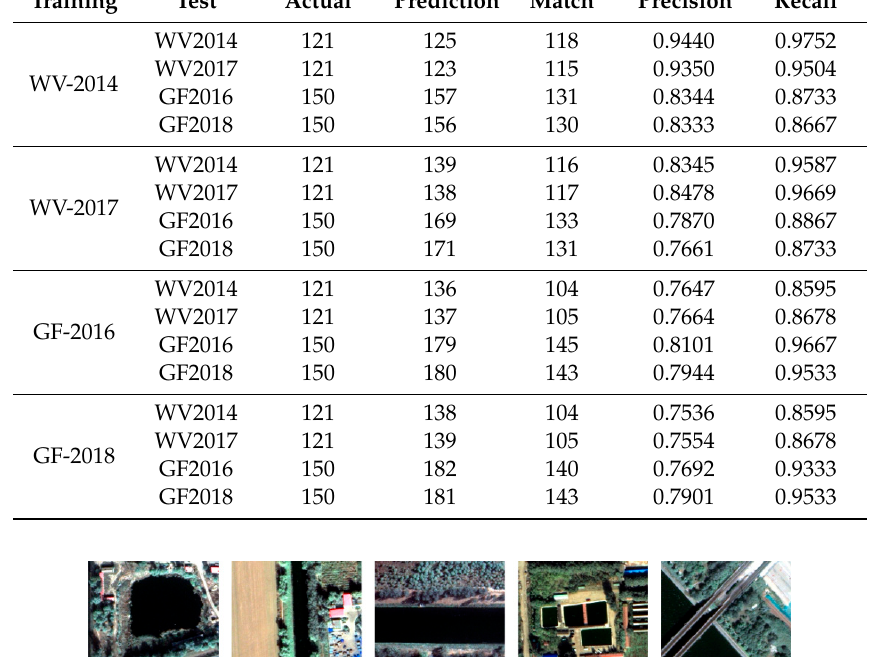
Table 7. Water recognition accuracy of the Mask R-CNN model trained with four di ff erent datasets at the object levels in four di ff erent test area.